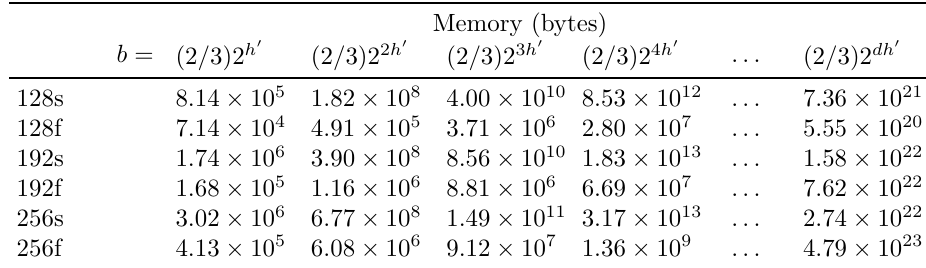
Table 13: Analysis of the branch caching countermeasure for all SPHINCS + parameter sets. The numbers b are rounded up to the next